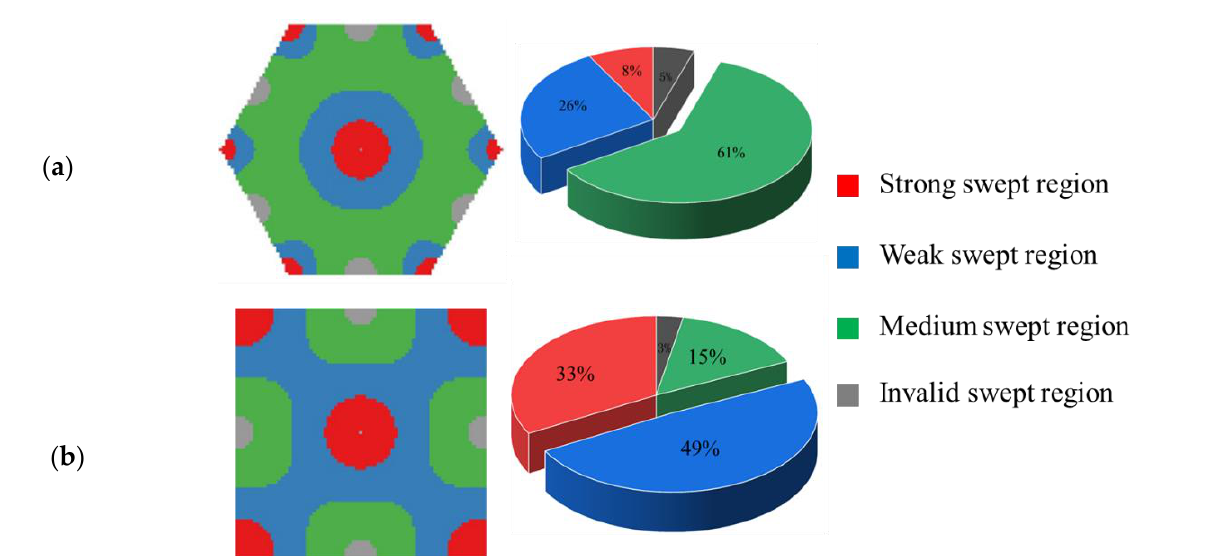
Figure 5. The distribution of swept intensity. ( a ) Inverted seven-spot well pattern; ( b ) five-spot well pattern.